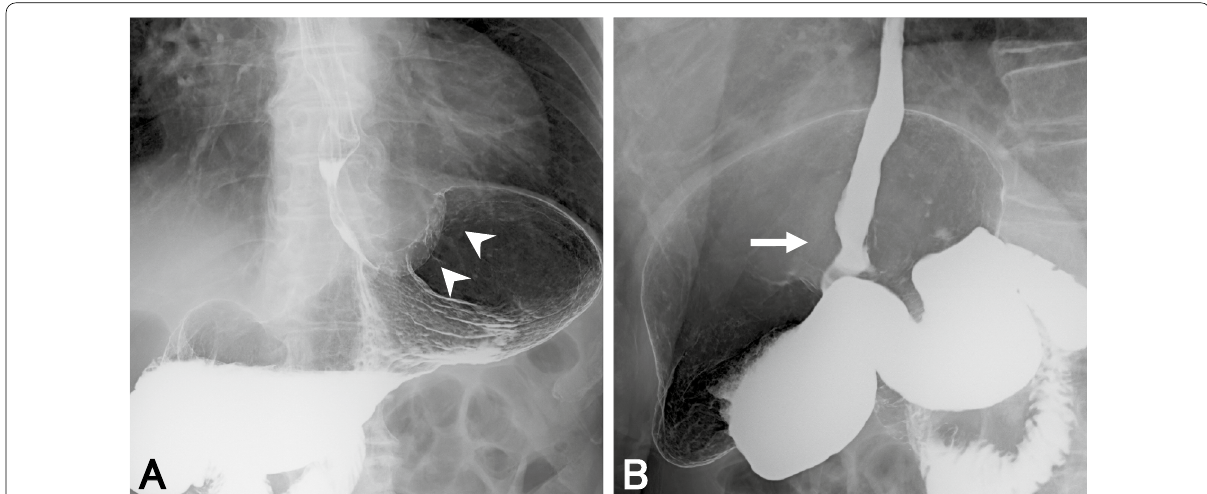
Fig. 2 Findings of barium meal study. A An elevated lesion is detected in the gastric cardia (arrowheads). B The tumor invades the lower esophagus approximately 15 mm from the EGJ with stenosis (arrow)